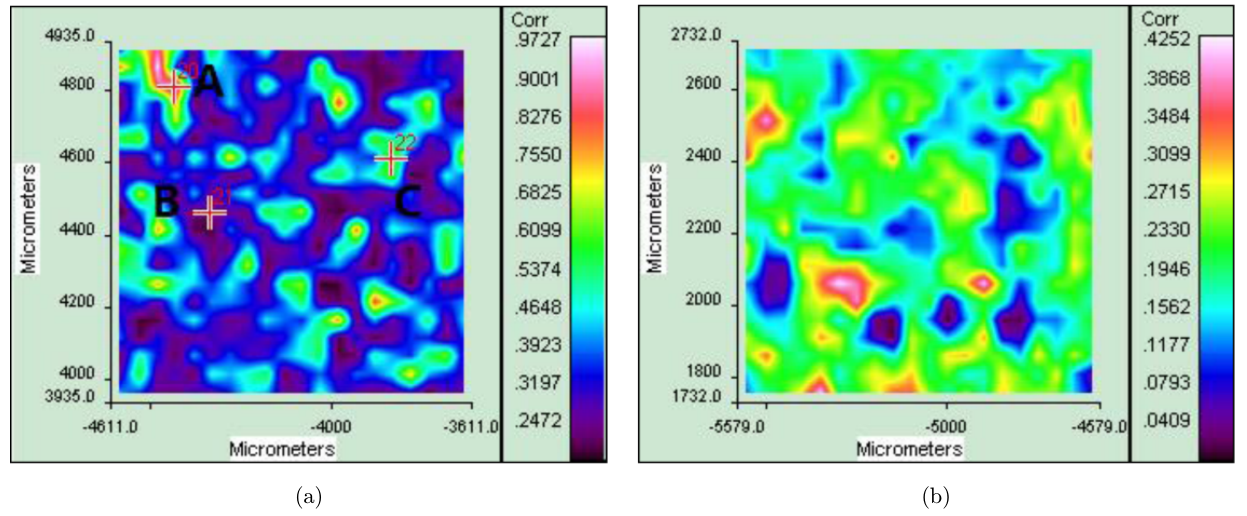
Fig. 4. Metformin near-infrared spectral images correlation coe±cient of sample No. 1 (a) and sample No. 36 (b), with correlation